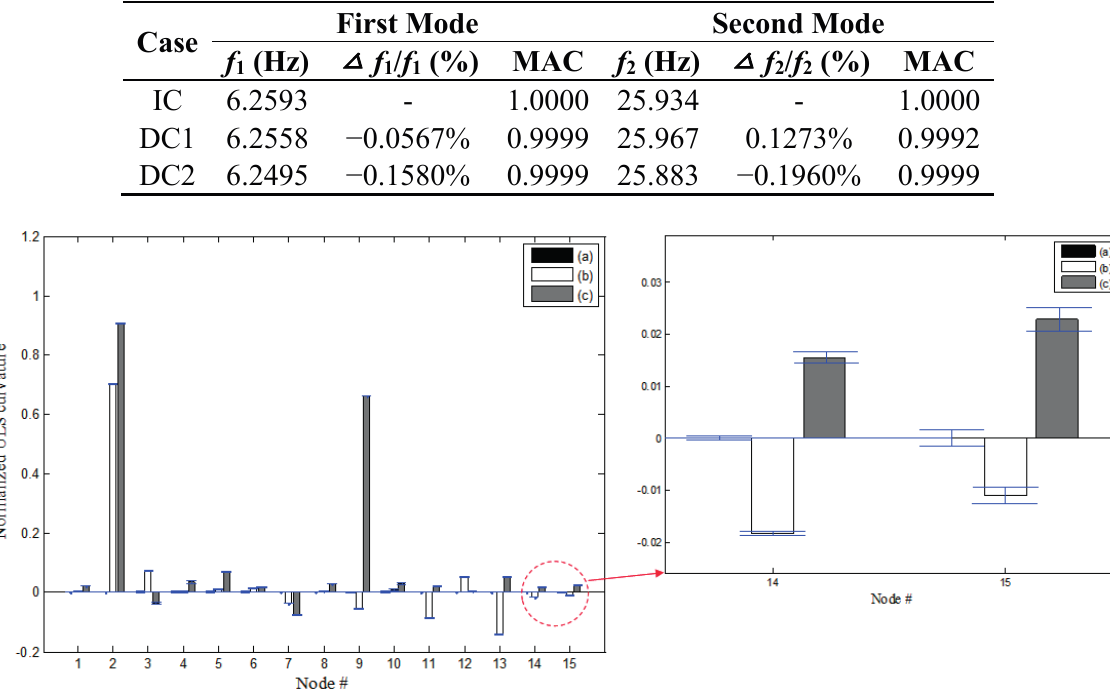
Figure 11. Changes in the NULS curvatures and its magnified plot at node 14, 15 with a